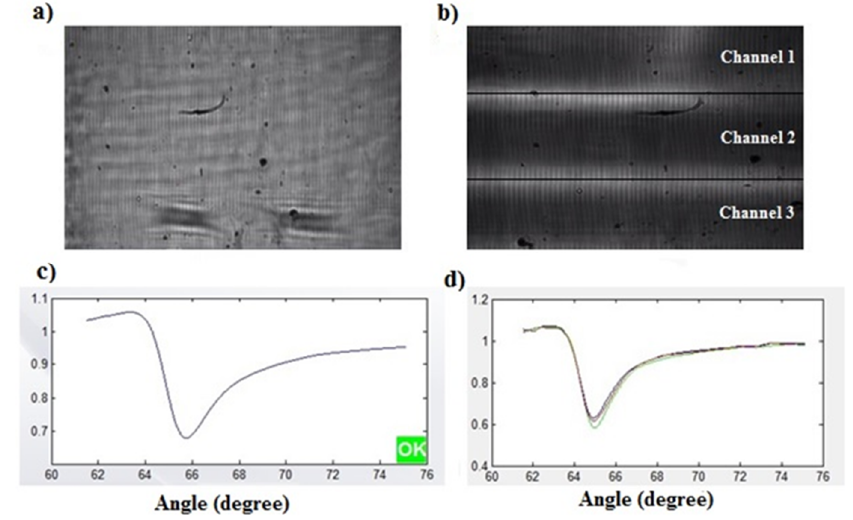
Figure 2. ( a ) The images of the gold surface with the single-cell chamber; ( b ) the images of the gold surface with the triple-cell chamber; ( c ) the resonance angle of DI water on the single- channel; ( d ) the resonance angle of DI water on the triple-channel.